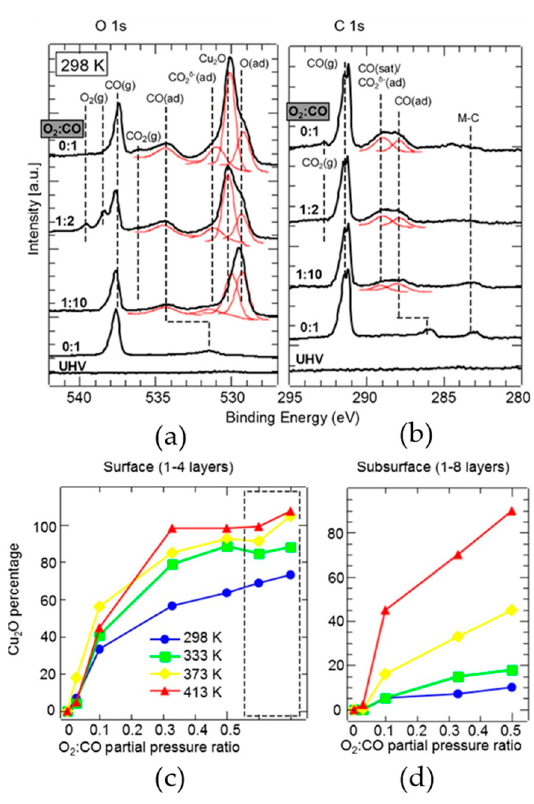
Figure 6. ( a , b ) are AP-XPS data of O 1s and C 1s peaks from a Cu(111) sample at 298 K. From bottom to top: in UHV, under 0.3 Torr of CO, under 0.03 Torr of O 2 + 0.3 Torr of CO, under 0.15 Torr of O 2 + 0.3 Torr of CO and after pumping the O 2 . Molecularly adsorbed CO peaks are observed at 531.5 eV of O 1s and 286.1 eV of C 1s on metallic Cu, and around 534.2 eV of O 1s, 287.9 eV of C 1s, and 289 eV (satellite) on the Cu 2 O covered region. The chemisorbed O peak is considered at 529.4 eV both on the metallic Cu and on Cu 2 O. The lattice O from Cu 2 O appears at 530.2 eV. An intermediate of the CO oxidation reaction, adsorbed CO 2 δ - , occurs at 531.5 eV of O 1s and 289 eV of C 1s. ( c ) Cu 2 O percentage (the rest is metallic Cu) of the surface estimated from the intensity ratio between O 1s (530.2 eV) and Cu 2p XPS peaks. ( d ) Cu 2 O percentage (the rest is metallic Cu) on the near-surface region (IMFP ~1.7 nm) estimated from the NEXAFS resonance at the Cu L3